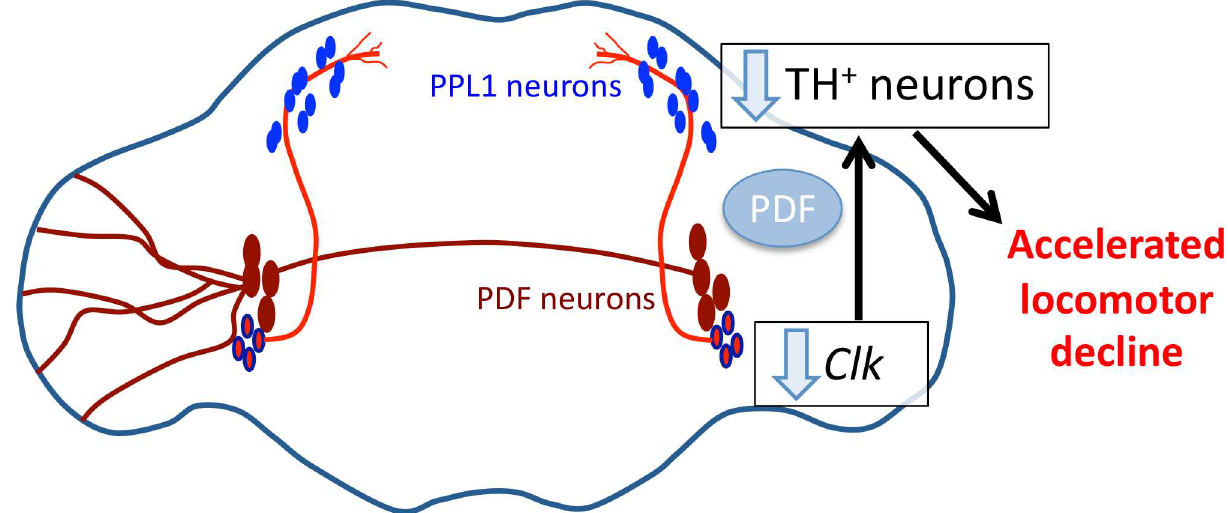
Fig 8. Proposed link between PDF-expressing and dopaminergic neurons in the Drosophila brain. Reducing Clk expressionin the s- LNv neurons(bright red with blue outline) accelerates ARLI, and perturbatesthe dopaminergic PPL1 cluster (somas shown in blue). The PDF receptor is involved,possiblyoveractivated by PDF releasedfrom the s-LNvs. In the Clk AR mutant, this could in particular negatively affect the MB-V1 dopaminergic neuron, either directly or indirectly, leadingto accelerated ARLI. The projections of the l-LNv neurons(brown red) onto the right brain hemisphere were omitted for